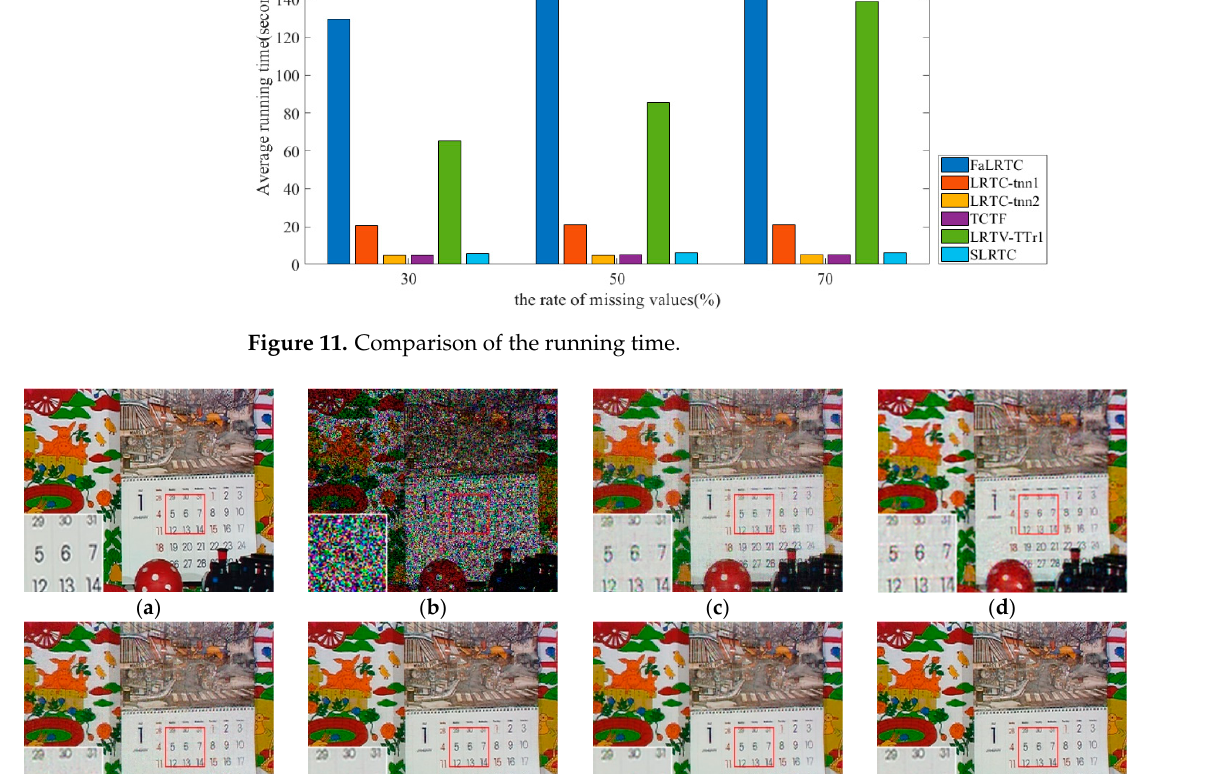
Figure 12. Visual effect comparison of different methods on the ninth frame completion of the Mobile video. The incomplete video contains 50% missing entries. ( a ) Original image; ( b ) Incomplete image; ( c ) FaLRTC (21.51 dB); ( d ) TCTF (21.80 dB); ( e ) LRTC-TNN1 (24.12 dB); ( f ) LRTC-TNN2 (28.09dB); ( g ) LRTV-TTr1 (26.15 dB); ( h ) SLRTC (29.97 dB).